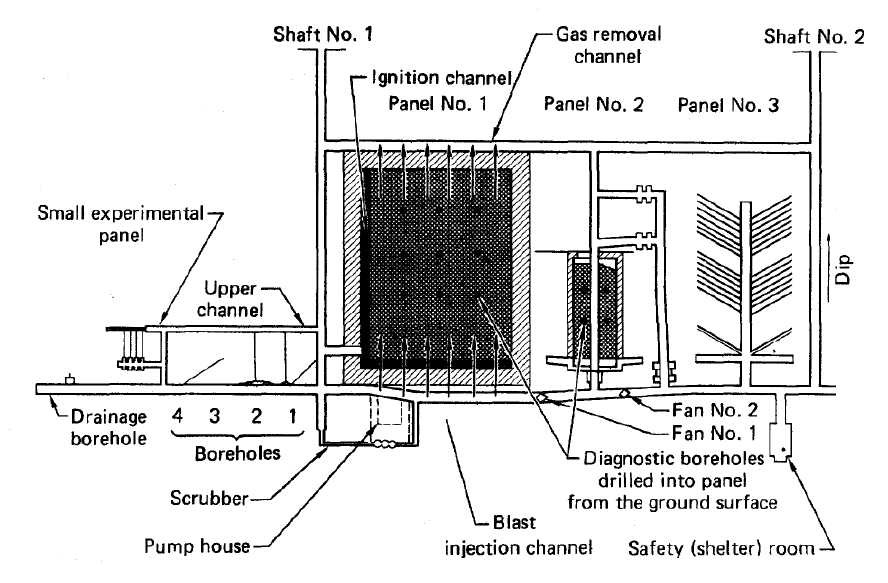
Figure 4. Plan of the UCG experimental mine in Lisichansk [7,